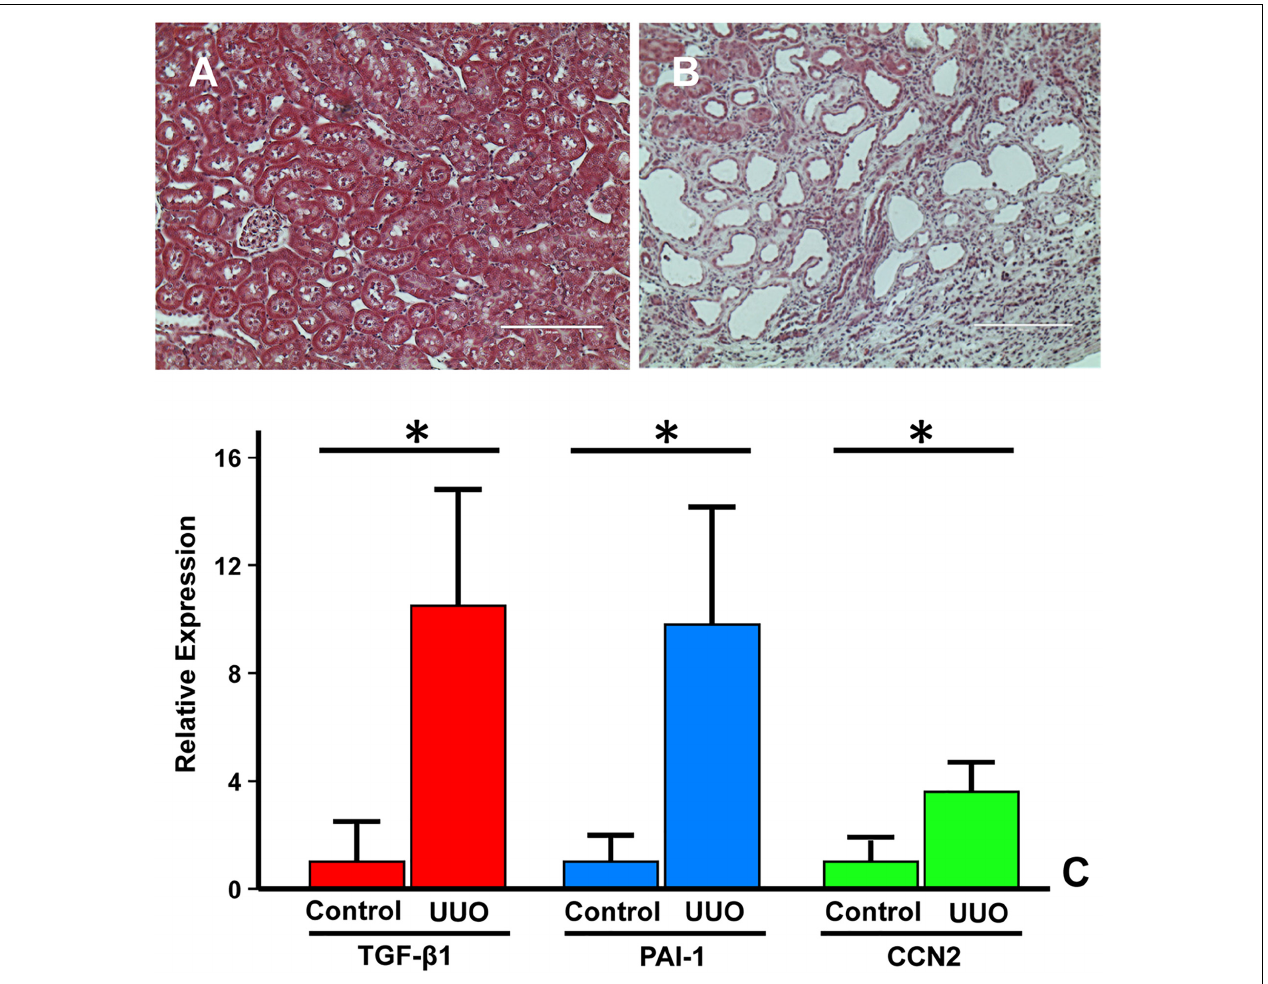
FIGURE 8 | Fibrotic response of the murine kidney to UUO. Compared to the relatively normal histology of the contralateral control or sham-operated kidney (A) , a dysmorphic and flattened epithelium with extensive tubular dilation, expanses of denuded basement membrane and accumulation of connective tissue (blue stain) in the expanded interstitial regions is evident in the obstructed kidney (B) . (A,B) , Trichrome stain. Morphometric analyses of immunohistochemical-stained paraffin-embedded sections of the UUO-injured kidney and the contralateral control 7–14 days post-surgery, revealed significant increases in PAI-1, TGF- β 1, and CCN2 in the obstructed kidney (C) . Histograms illustrate the mean ± SD staining intensity (ImageJ threshold analysis) for TGF- β 1, PAI-1, and CCN2 between the two experimental groups. * p <